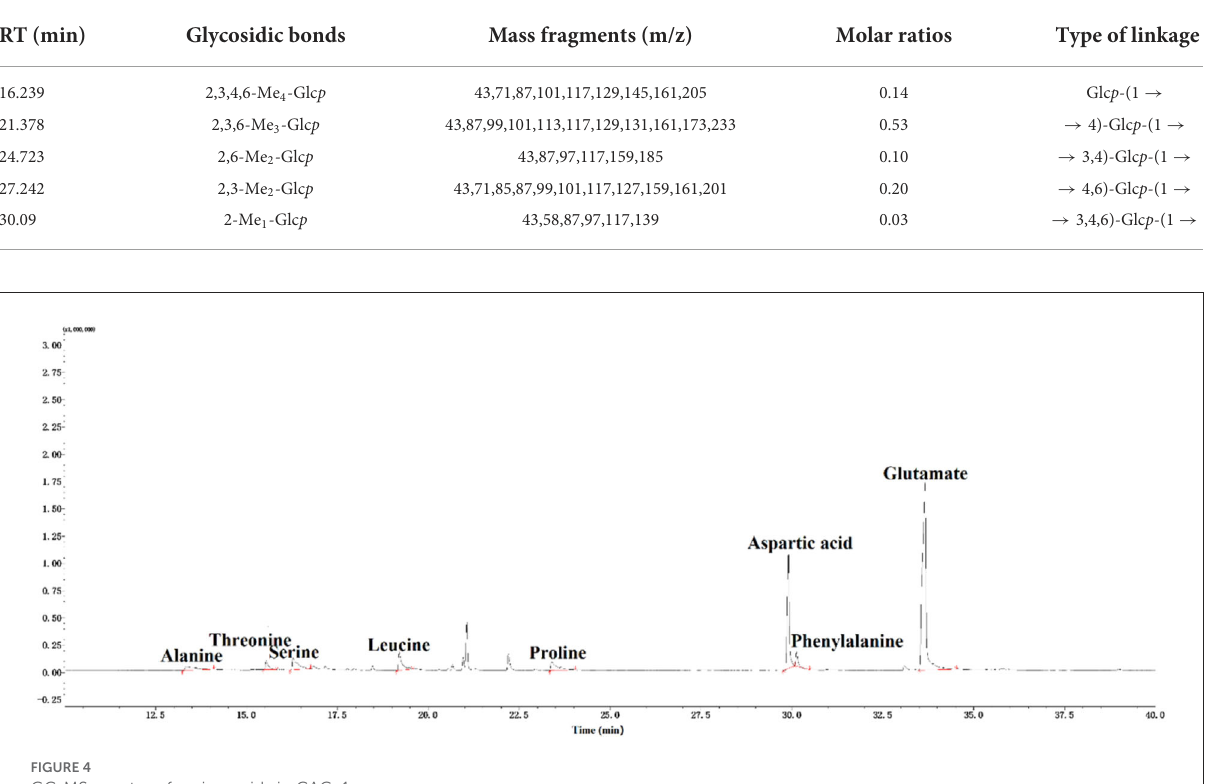
TABLE 3 Amino acids in CAG-1.